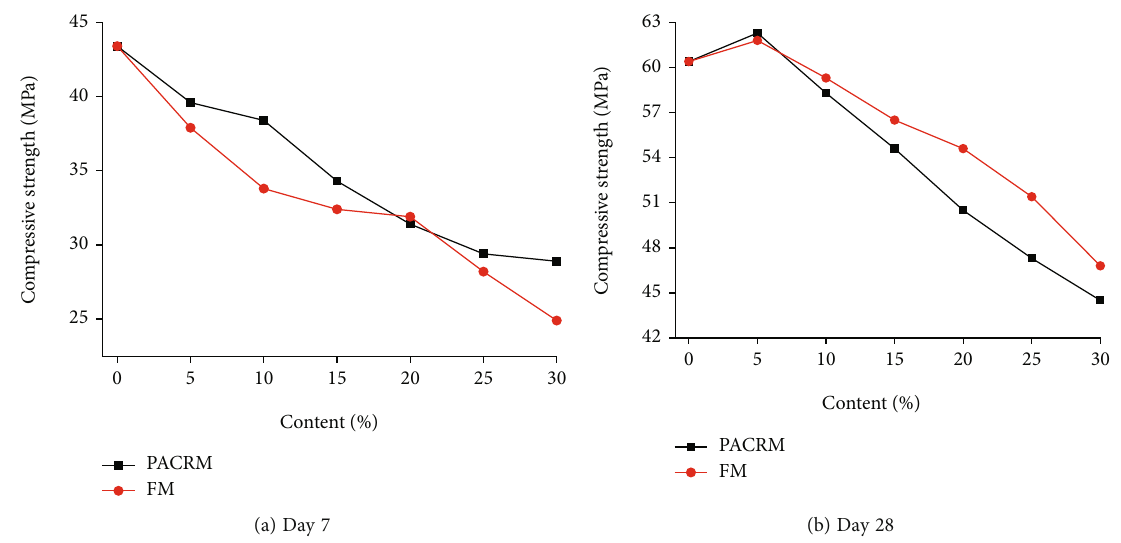
Figure 7: Compressive strength of cement mortar mixed with PAC waste residue and fl y